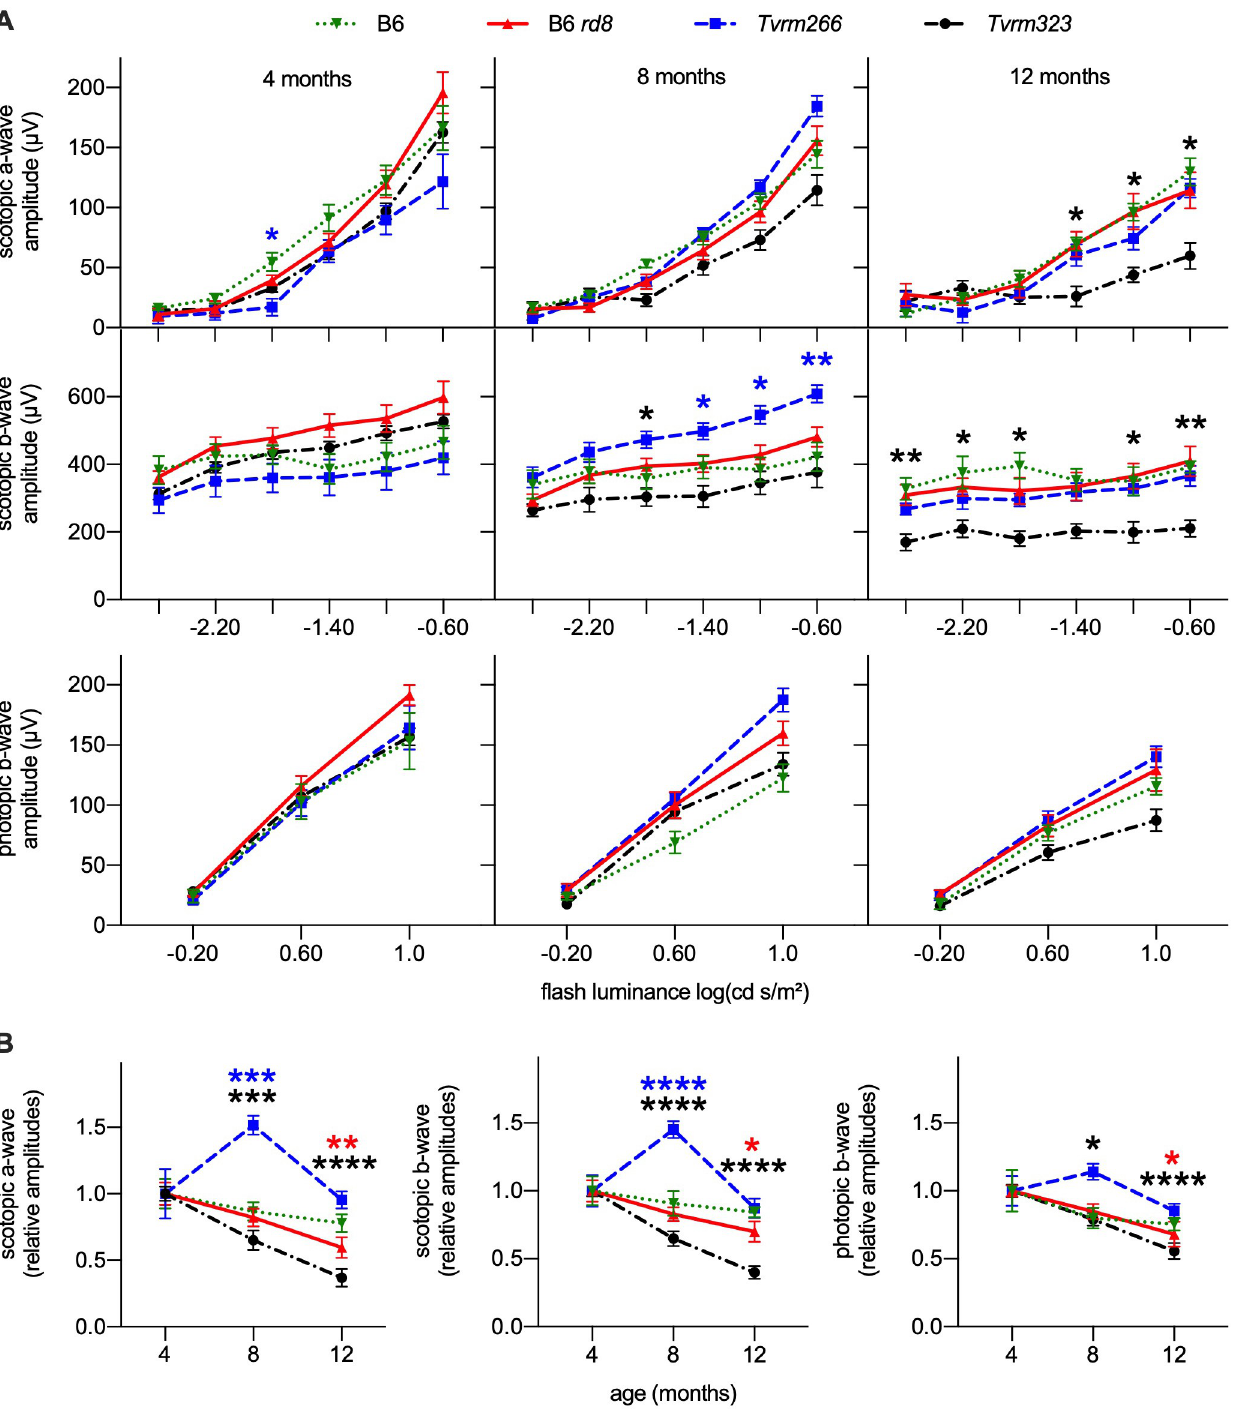
Fig 9. ERG analysis of B6, B6 rd8 , Tvrm266 , and Tvrm323 mice at four, eight, and 12 months of age. A. Scotopic and photopic response amplitudes as a function of flash luminance. Asterisks show statistical significance in a comparison to B6 rd8 and are colored as in the legend to indicate the strain compared. � p < 0.05; �� p < 0.01. Values indicate mean ± SEM; n = 6–26. B. Response amplitudes at the highest flash luminance as a function of age, normalized to the mean amplitude at four months of age. Legend is the same as in panel A. Asterisks indicate statistical significance compared to the value at four months of age and are colored as in the legend in panel A. � p < 0.05, �� p < 0.01; ��� p < 0.001; ���� p < 0.0001.